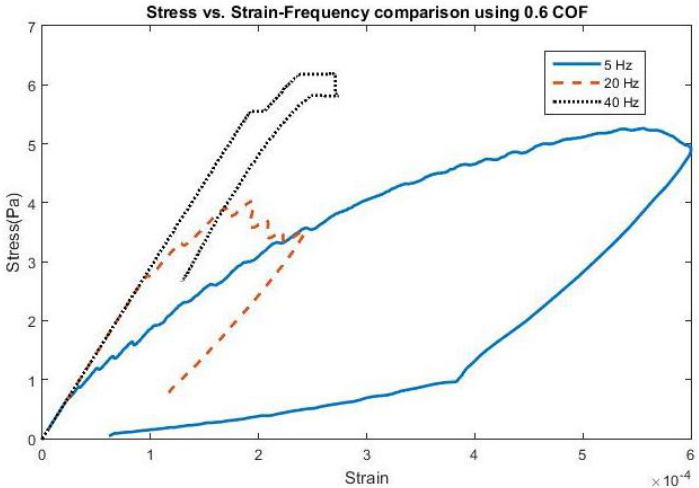
Figure 1. Stress vs. Strain for a 4-micron amplitude at various applied frequencies using a coefficient of friction (COF) of 0.6.